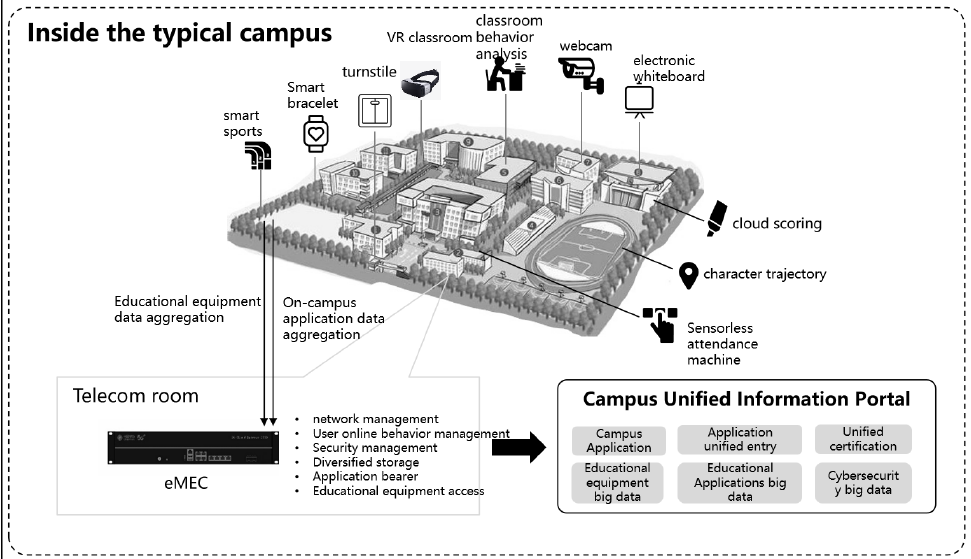
Figure 2. Applications of smart education in campus